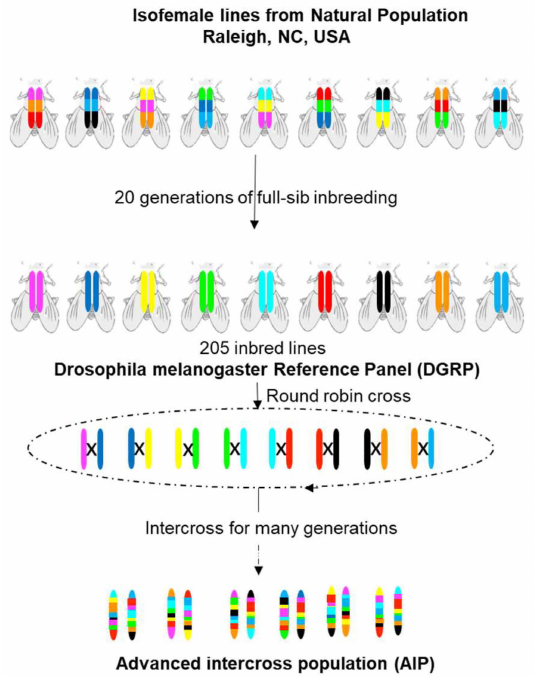
Figure 2. Generation of Drosophila melanogaster Genetic Reference Panel (DGRP) and Advanced Intercross Population (DGRP-AIPs). The DGRP corresponds to a sequenced panel derived from a natural fly population of Raleigh, NC (USA), and it was generated through 20 generations of full-sibling mating. The AIPs lines were derived from the DGRP by round-robin crossing and were then